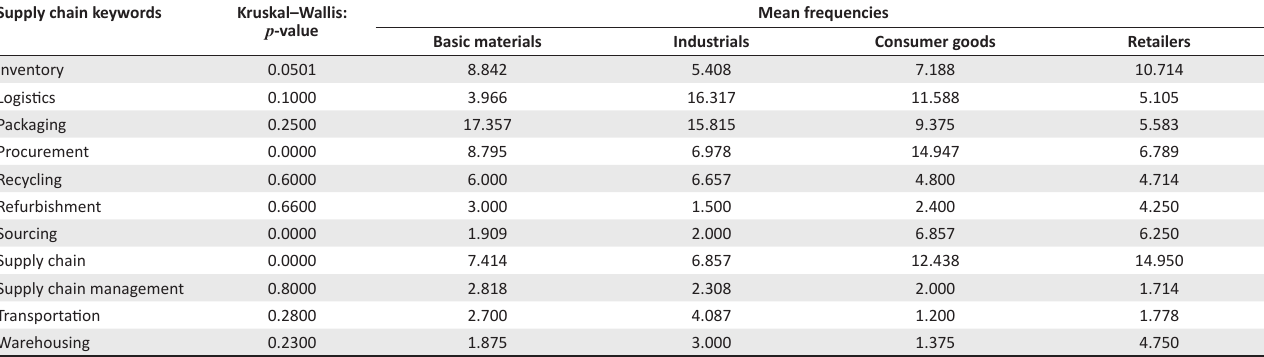
TABLE 4: Kruskal–Wallis sector comparison of sustainability keywords.